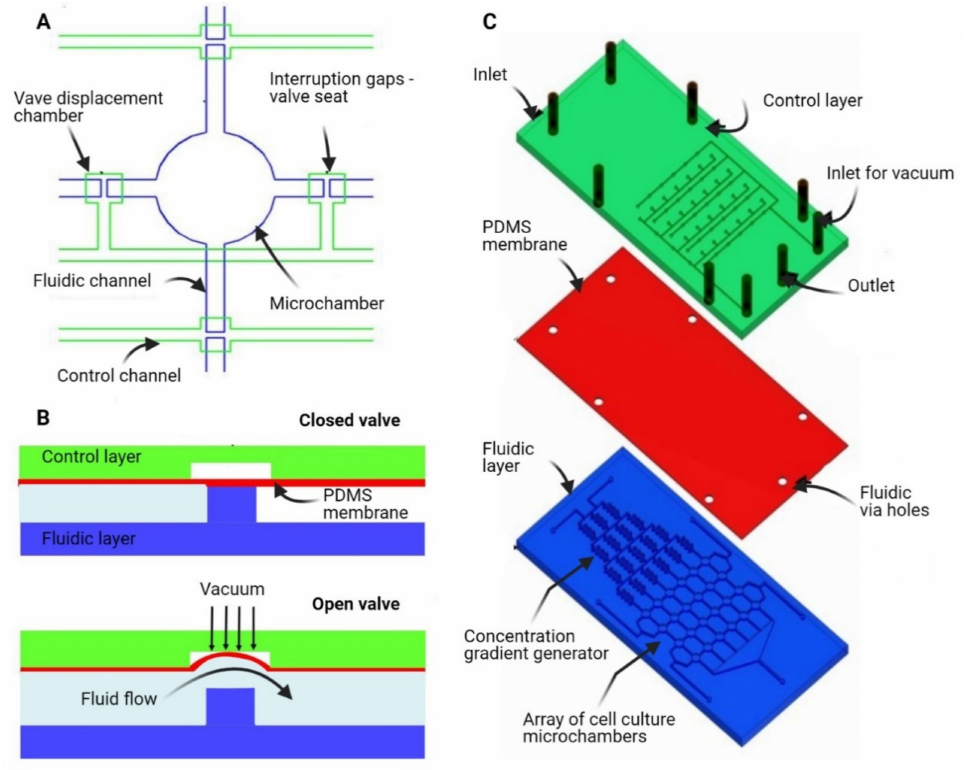
Figure 3. ( A ) Control of fluid flow in single cell culture element by two pairs of row and columnar valves; ( B ) opening and closing of valves by applying or releasing vacuum in the control channel to deflect or release flexible PDMS membrane; ( C ) 24 (6 × 4) element cell culture array with three-layer